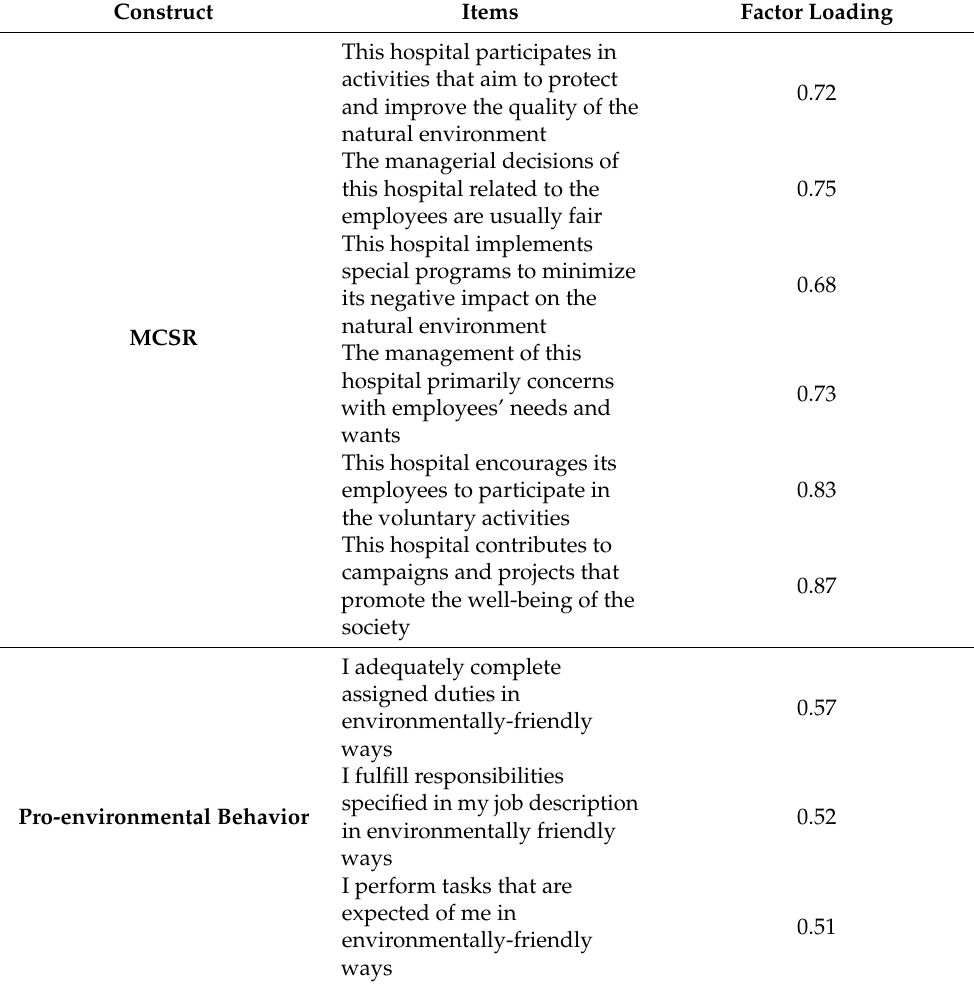
Table 2. Items with factor